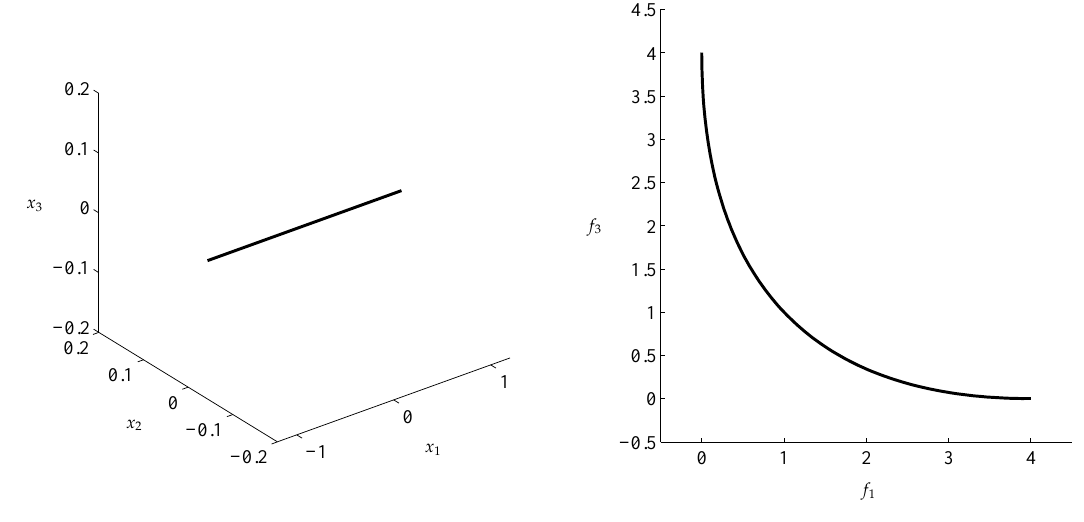
Figure 13. Pareto set (left) and front (right) of MOP